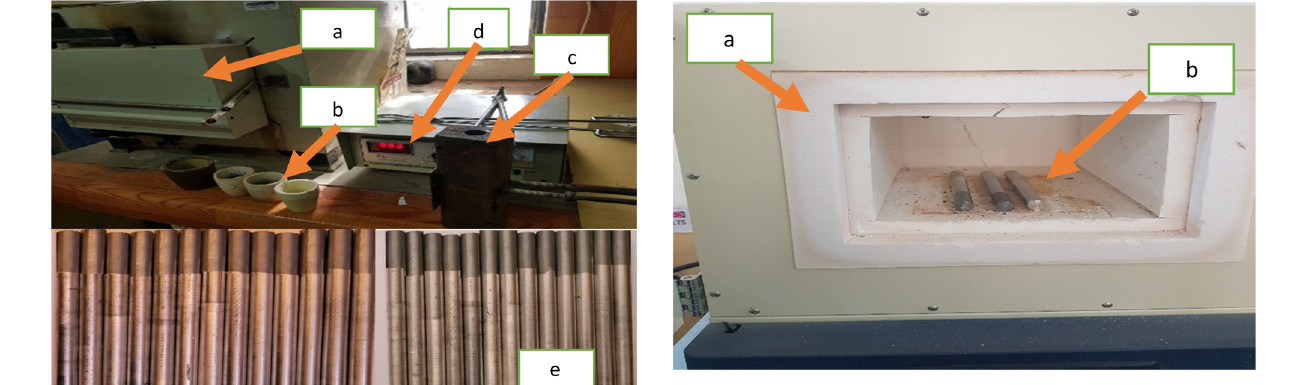
Figure 6: Annealing process: ( a ) furnace and ( b )